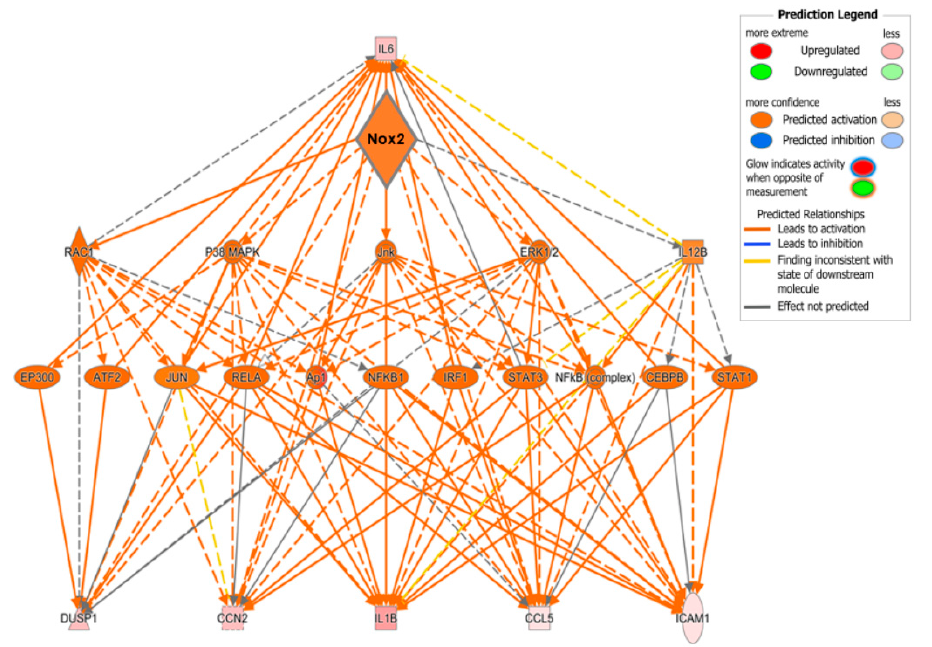
Figure 9. Predicted regulatory network influenced by Nox2 in PPAR α − / − mice subjected to pressure overload. IPA was used to generate the network. Node colour represents upregulated genes (red) and downregulated genes (green). Node shapes represent functional classes of gene products; rectangles for cytokines, triangles for phosphatases, concentric circles for groups or complexes, diamonds for enzymes, horizontal ovals for transcriptional regulators or modulators, and vertical oval for transmembrane receptor.